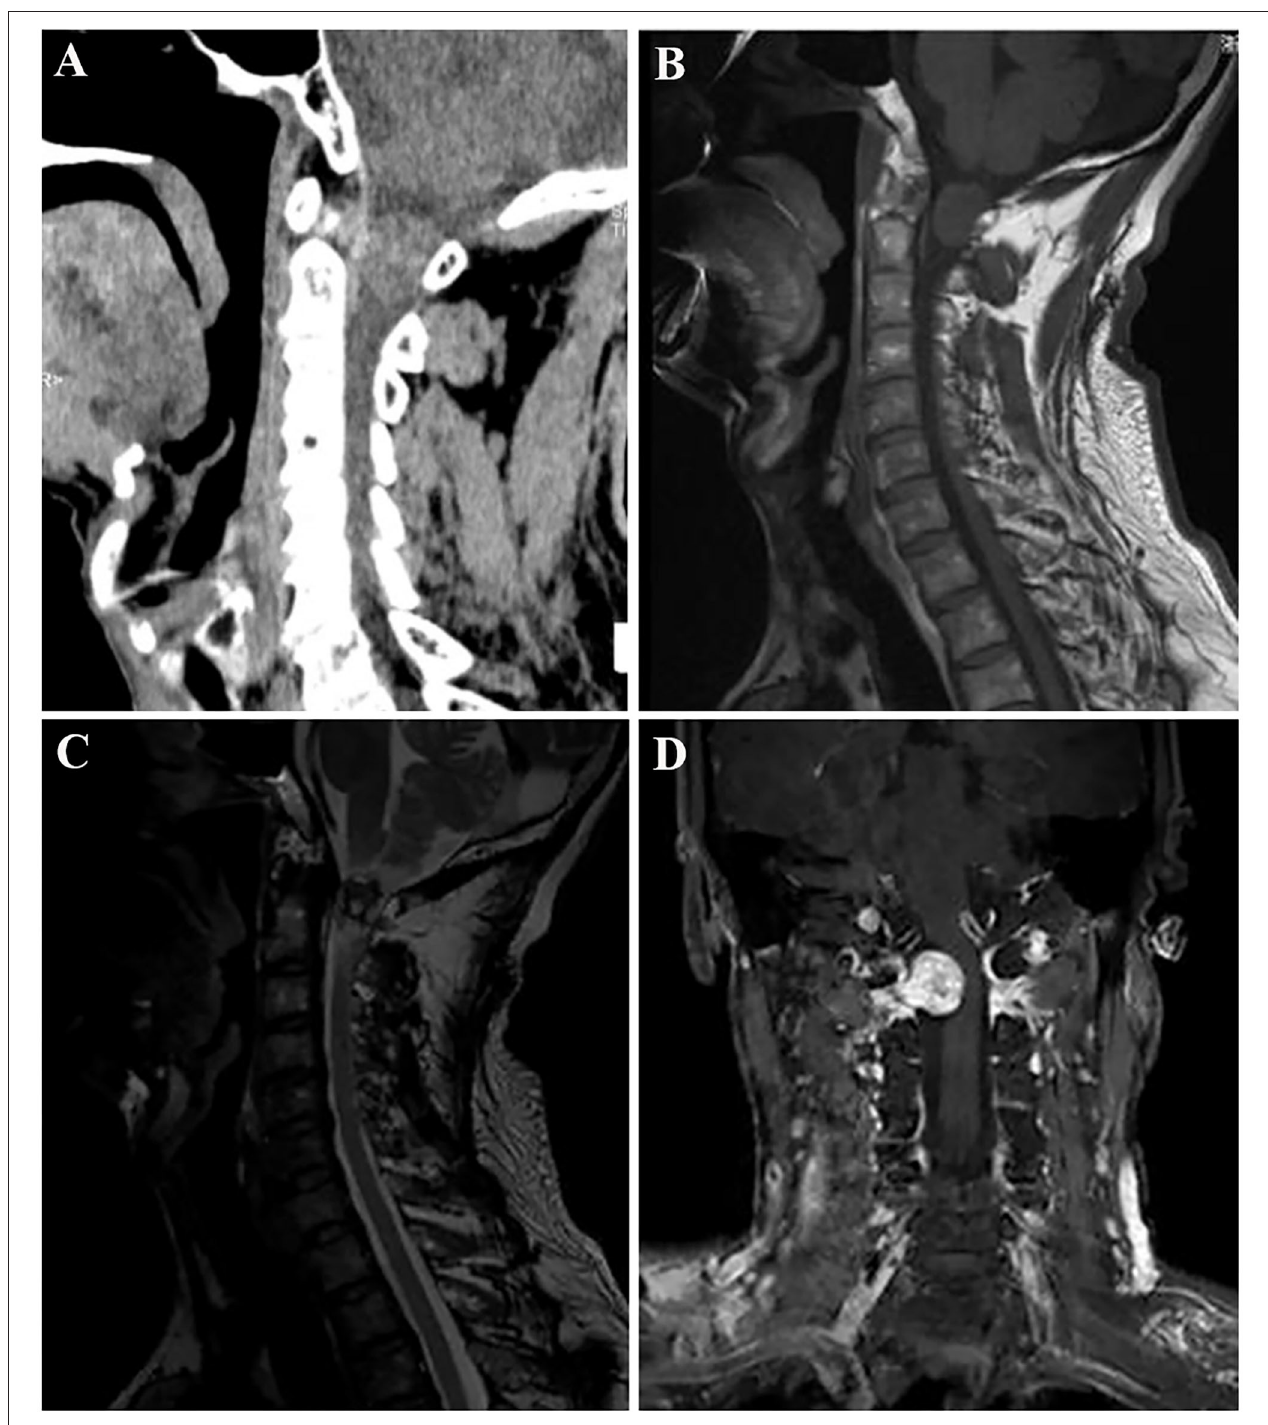
FIGURE 1 | Spine computed tomography (CT) demonstrated a slightly hyperdense nodule lesion with a little spot low and high density of the C1-2 level, and well-circumscribed without obvious bone destruction (A) . Contrast-enhanced magnetic resonance imaging (MRI) of the spine; the lesion was isointense on T1-weighted images (B) , and hypo- to hyperintense on T2-weighted images (C) . After intravenous administration of gadolinium, the tumor showed obvious peripheral enhancement, presenting a growing tendency along the right second intervertebral foramen and compressing the spinal cord to the left side (D) .